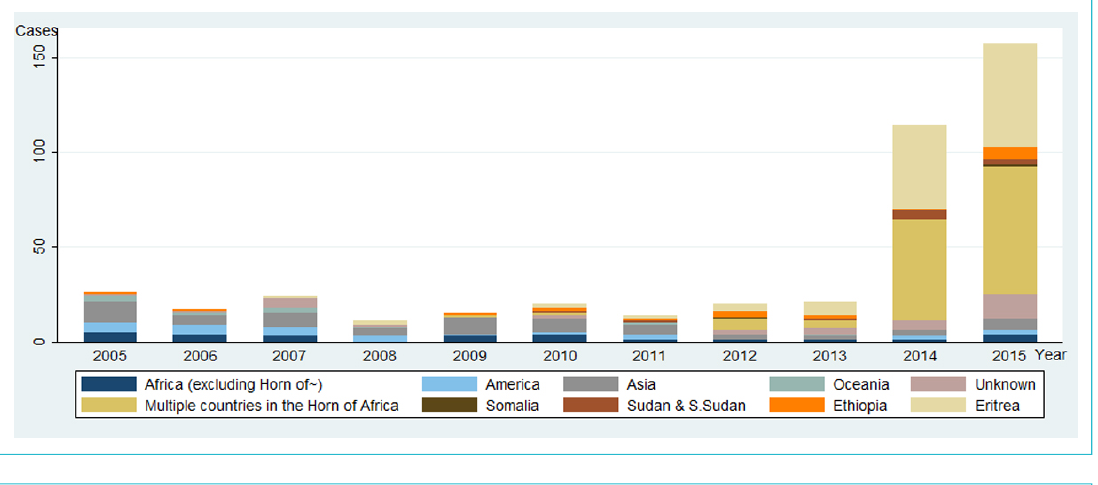
Figure 3: Reason for travel of patients with Pv malaria imported from endemic countries, among cases reported in Switzerland to the Federal Office of Public Health, 2005–2015 (n = 437).Immigration: category without distinction between refugees, asylum seekers or migrants; VFR: visiting friends and